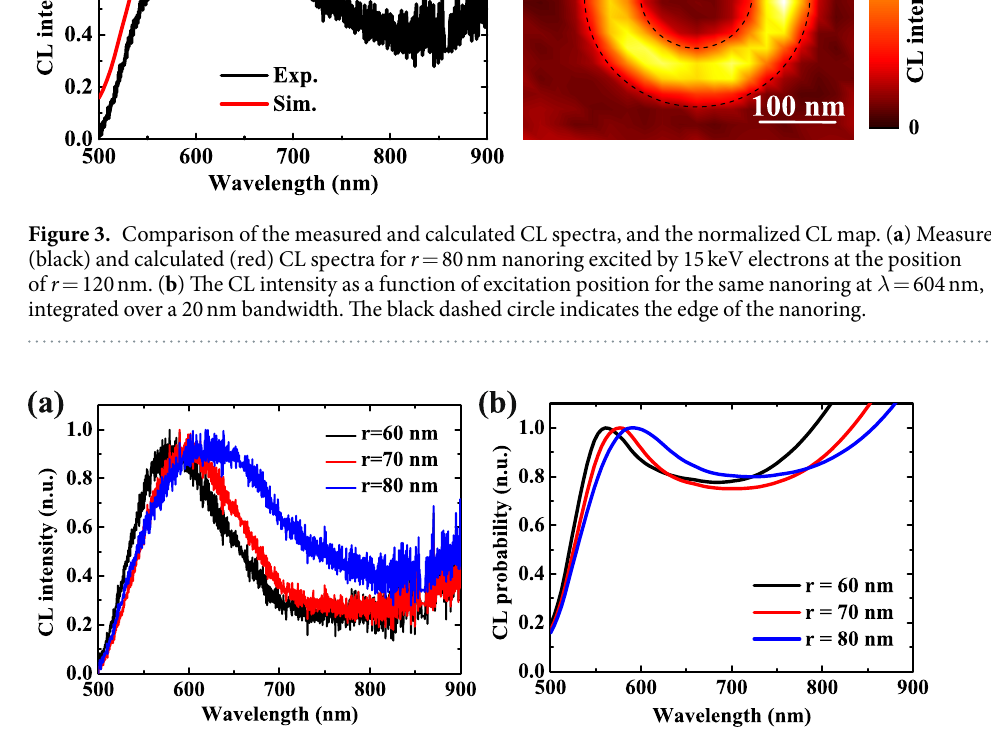
Figure 4. Comparison of the measured and calculated CL spectra with different radii. ( a ) Measured CL spectra for Au nanorings with different radii r = 60, 70 and 80 nm, the quadrupolar resonance wavelength λ = 563, 590 and 604 nm, respectively. ( b ) Calculated CL spectra for the geometries corresponding to the measurements of ( a ), the quadrupolar resonance wavelength λ = 561, 578 and 592 nm,